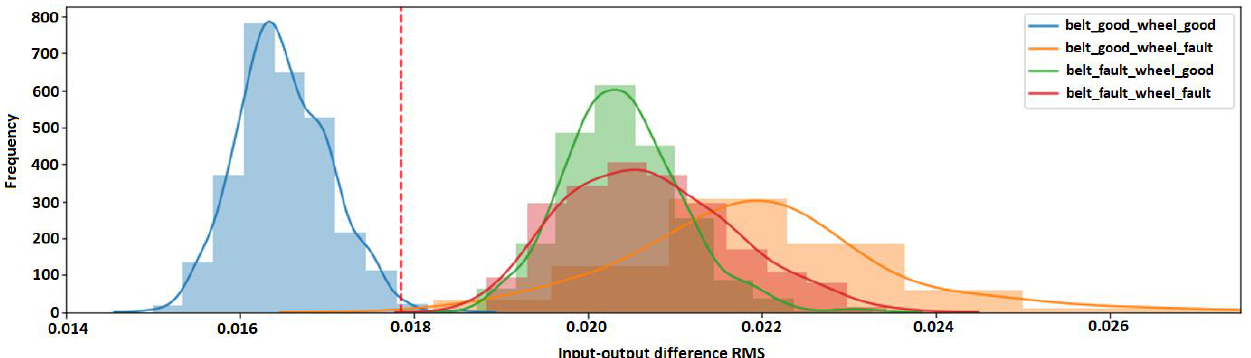
Figure 8. Distribution of autoencoder mapping errors for each damage-related class for vertically positioned sensor. Table 1. Summarization for results reached during